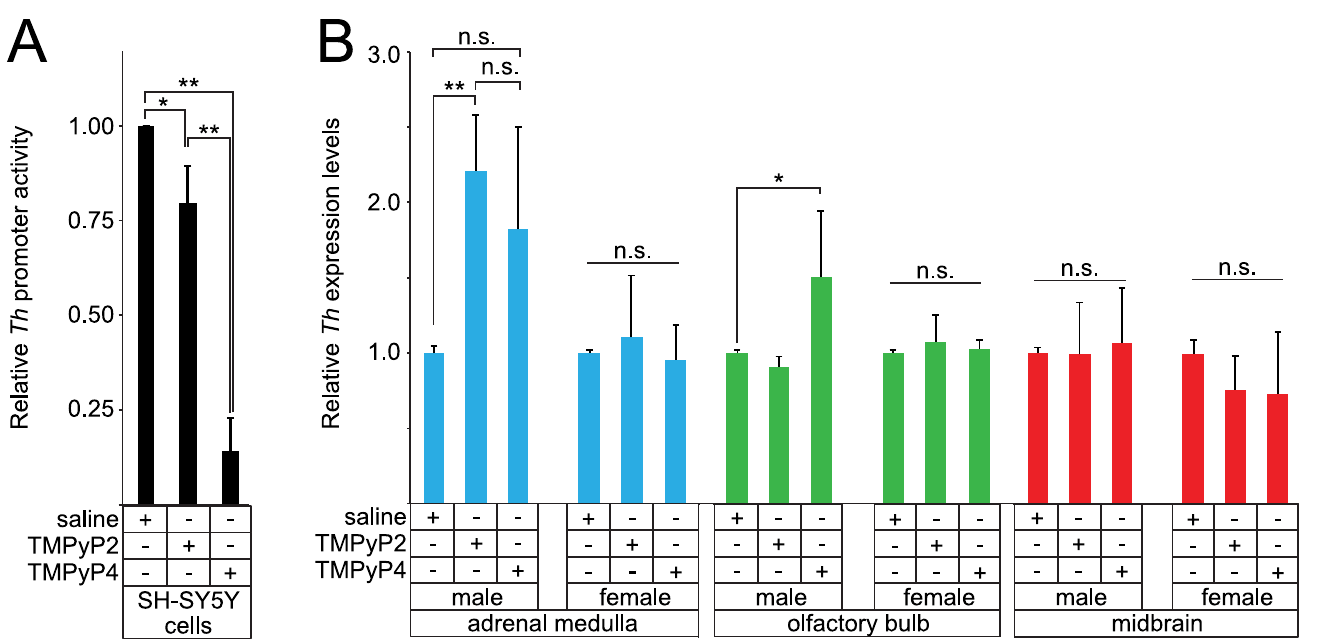
Fig 2. In vitro vs . in vivo modulation of Th expression by TMPyP4. A , transcription assays with SH-SY5Y cells transfected with a reporter under the control of the rat 4.5kb Th promoter that are also treated with either saline, TMPyP2 or TMPyP4. Mean relative promoter activities are shown with error bars representing the standard deviation. ** indicates p < 0.001, * indicates p = 0.02 and n.s. indicates not significant. B , Th transcript levels, as measured by quantitative RT-PCR, in the adrenal glands, olfactory bulb and midbrain of adult mice administered either saline, TMPyP2 or TMPyP4 (n = 8 for both male and female). Mean relative transcript levels are shown with error bars representing the standard error of the mean. ** indicates p < 0.01, * indicates p = 0.03 and n.s. indicates not